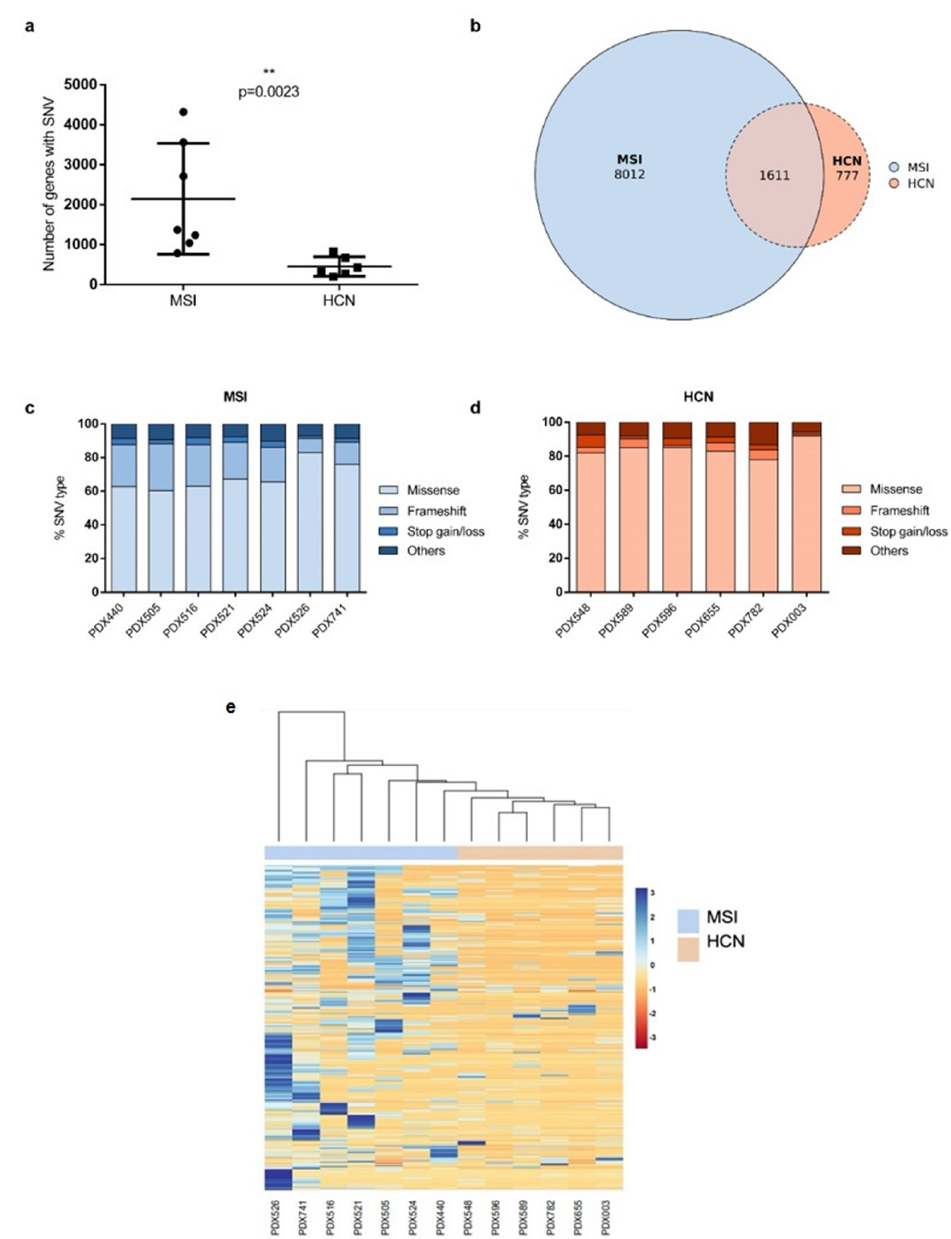
Figure 2. Molecular characterization of PDX models based on single-nucleotide variants. ( a ) Comparative analysis of the total number of genes carrying SNVs in each PDX model, grouped as MSI and HCN. ( b ) Venn Diagram showing the number of genes with SNVs for each PDX group, MSI (blue) vs. HCN (orange) and the overlap between them. ( c , d ) Percentage of the most frequent types of SNV found in MSI and HCN PDX models. Others classification included all minority SNVs such as spliced donor/acceptor variant, start lost or any other alteration that did not fit with indels, missense or stop gain/loss mutations. ( e ) Hierarchical heatmap clustering analysis based on the frequency of genes carrying SNVs for both MSI and HCN PDX